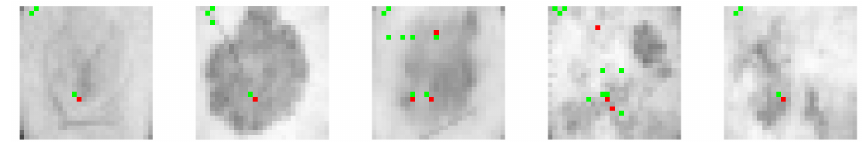
Figure 18. Samples belonging to the “benign” class, sharing a rule. The first and the fifth case are covered by a single rule, while the others present a higher number of colored dots related up to three activated rules.